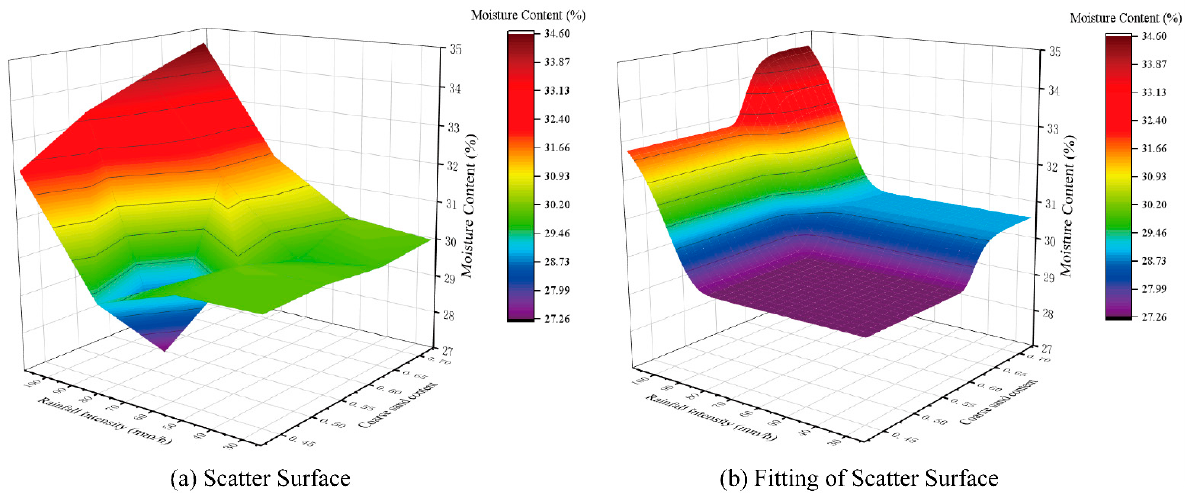
Figure 19. IPM model fitting.